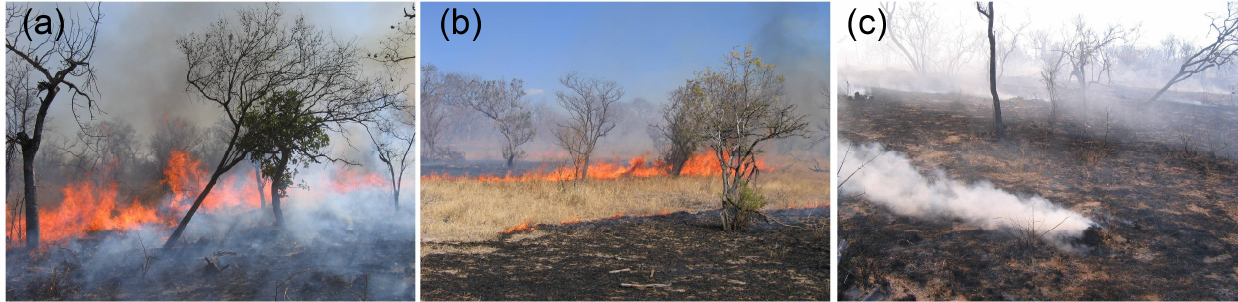
Fig. 2. Example photographs of the savannah burns studied here, taken during (a) the headfire stage of Fire 1 (N’waswitshaka) and (b) the headfire stage of Fire 2 (Skukuza). Two flame fronts are seen in (b) , the still existing backfire flame front that is closest to the camera, and the more distant headfire flame front that is clearly more intense, with higher flame heights and a more rapid rate of spread. The headfire flame front therefore consumes more fuel and produces more emissions per unit time than does the backfire flame front, and thus dominates smoke production during the headfire stage. Also note the apparently more substantial “smoking zone” in (a) in comparison to (b) . Photograph (c) is also of the N’waswitshaka plot (Fire 1) during the subsequent RSC stage. This demonstrates the effect that elephant dung located in the plot interior had on the amount of smouldering combustion, which is expected to have contributed significantly to emissions from the headfire “smoking zone” seen in (a) . Dung ignited at the start of the burn was seen to smoulder, and sometimes even flame, well into the RSC stage.